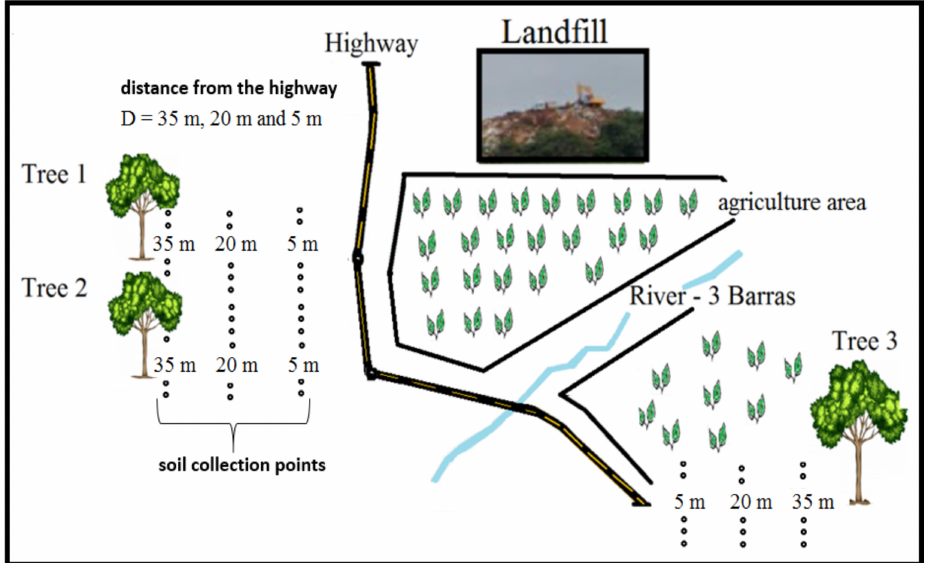
Figure 1. Schematic drawing of the sampling location—trees 1, 2 and 3 (plant samples and distance from the highway D = 5, 20 and 35 m), the three parallel lines (soil sample) from both sides of the MS-40 highway, and surroundings (river, landfill and agricultural